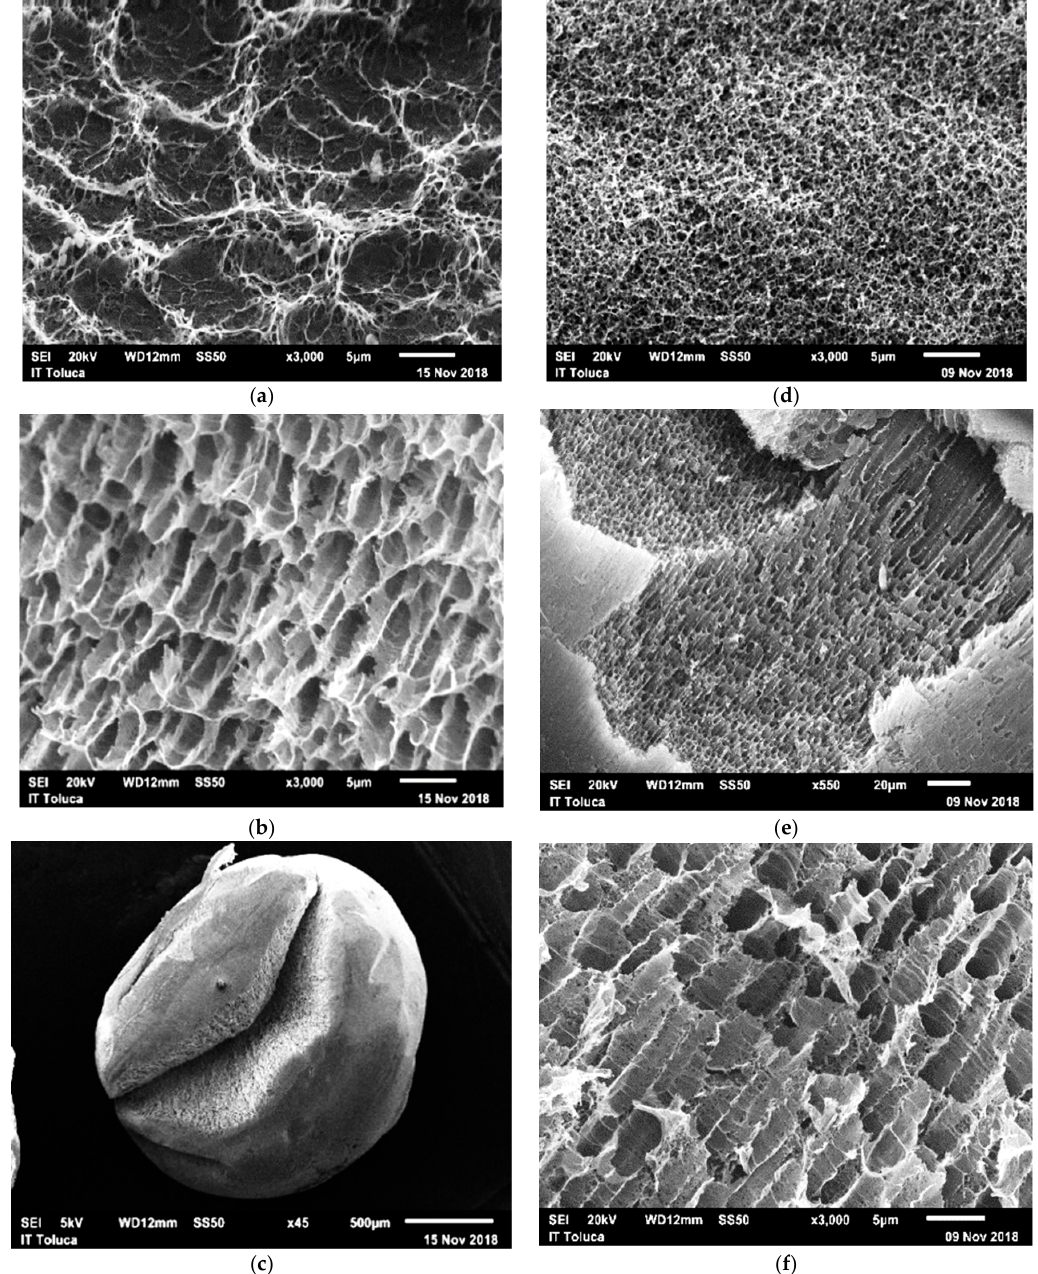
Figure 3. Micrographs of the Ch-PVA-NaOH-TPP hydrogel; before the adsorption process ( a ) surface with ridges, valleys, and pores; ( b ) the presence of channels with porous surface walls facing the same direction; ( c ) morphological difference between the external and internal surface of the hydrogel bead. Hydrogel micrograph Ch-PVA-NaOH-TPP; after the adsorption process ( d ) morphological difference between the external and internal surface of the hydrogel bead; ( e ) channels facing in the same direction and pores in the surface wall of the channels; ( f ) homogeneous and porous surface.